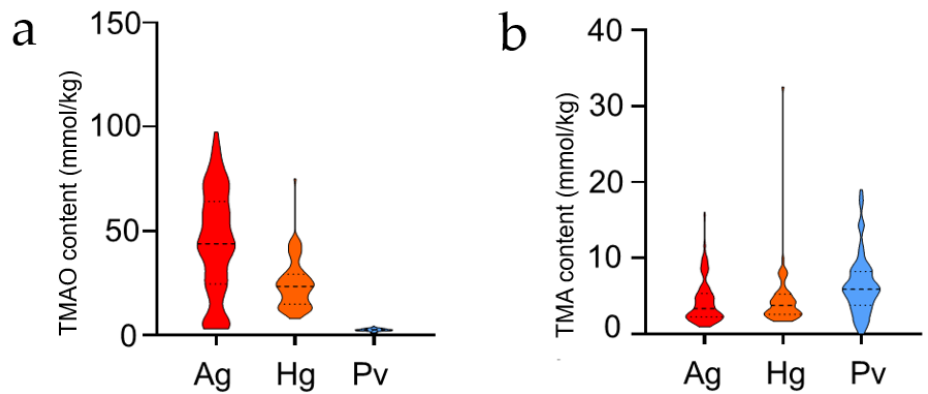
Figure 1. ( a , b ) Violin diagram of total TMAO and TMA content of two hadal amphipods and a shallow water decapods P. vannamei . Red represents A. gigantea , orange represents H. gigas , and blue represents P. vannamei . Except the comparison with P. vannamei , we also compared our study with the reported TMAO concentrations in amphipod species [30,41]. The comparisons are shown in Table 3. Generally, TMAO concentrations in the hadal A. gigantea and H. gigas are higher than those of the shallow amphipod in Lake Baikal (Table 3). Meanwhile, it can be easily concluded that the TMAO concentration increases generally with increasing depth. As for hadal H. gigas , the TMAO concentration of the combined tissues (our study) is closed to the data of the whole body in Downing’s study [30]. Table 3. The TMAO concentrations of amphipods from fresh water and marine environments (unit: mmol/kg wet